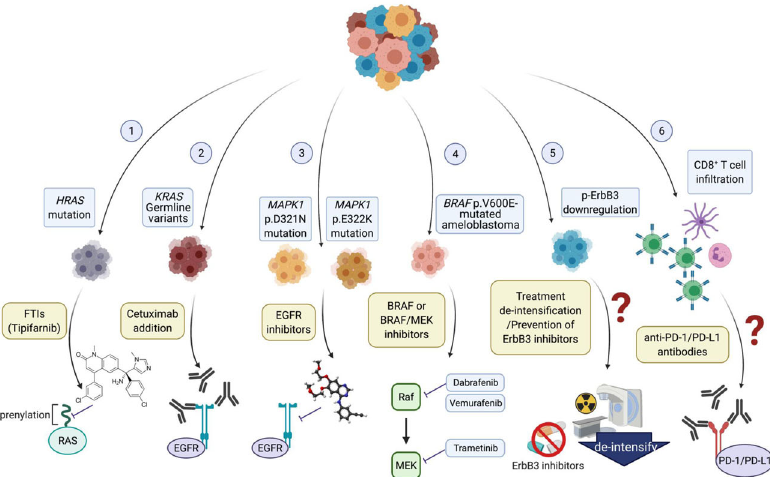
Fig. 3 Proposed precision treatment strategies for MAPK pathway-mutated head and neck cancer. (1) FTIs, particularly tipifarnib, is currently under FDA fast track designation for HRAS -mutant HNSCC treatment; (2) HNSCC with KRAS germline variants are druggable with cetuximab addition; (3) MAPK1 mutations are targetable by EGFR inhibitors; (4) BRAF p.V600E-mutated ameloblastoma are exceptionally sensitive to and could be subject to BRAF monotherapy or BRAF/MEK combination therapy; (5) Treatment de-intensi fi cation or potentially “ not-to-use ” of ErbB3 inhibitors may need to be considered in MAPK-mutatedp-ErbB3 downregulated HNSCC. (6) CD8 + T cell in fi ltration in MAPK-mutant HNSCC may constitute better clinical outcome to anti-PD-1/PD-L1 inhibitor